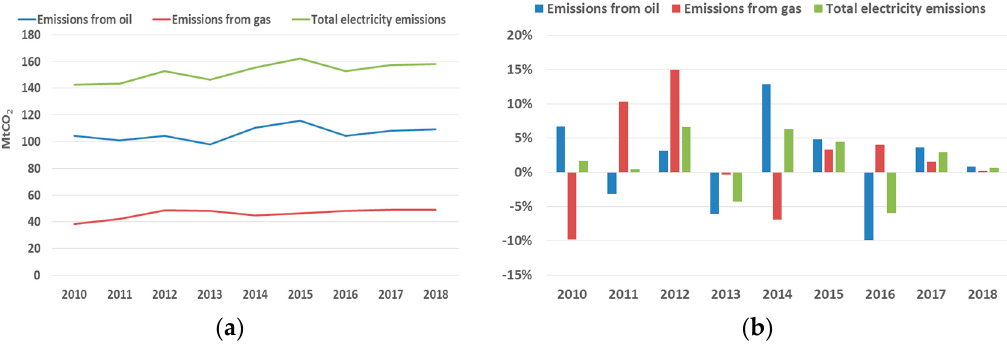
Figure 15. Electricity sector CO 2 emissions ( a ) absolute ( b ) percentage change year on year (2010–2018). Source: Authors based on Enerdata.